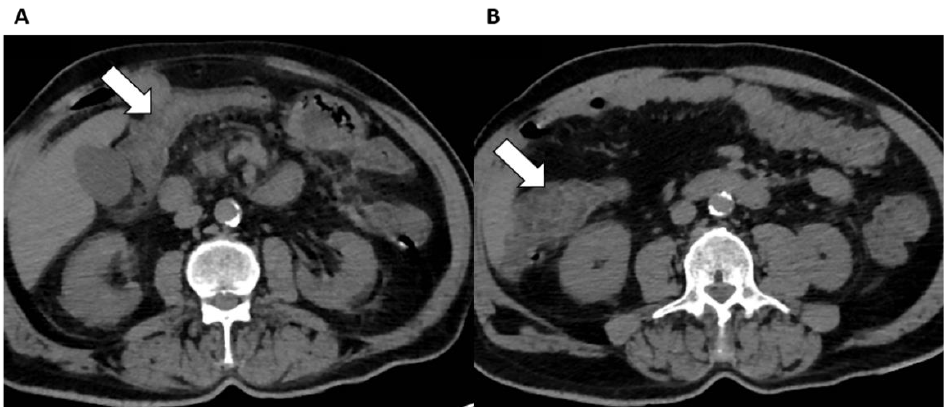
Figure 5. Intestinal findings in a COVID-19 patient admitted to the Emergency Department for abdominal pain. ( A , B ) Unenhanced axial abdominal CT images show bowel wall thickening in the transvers colon (arrows) with adjacent fat stranding consistent with intestinal involvement with ischemic lesions.